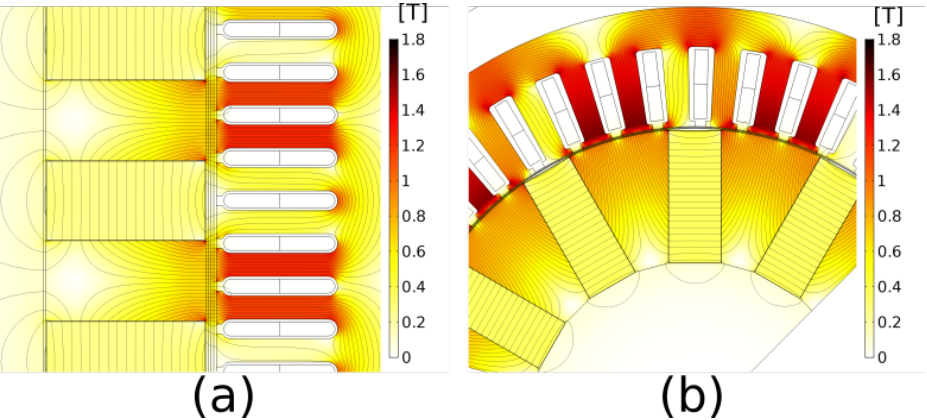
Figure 1. The no-load default cases for the linear and rotating electrical machines in ( a , b ), respectively. Table 1. Machine